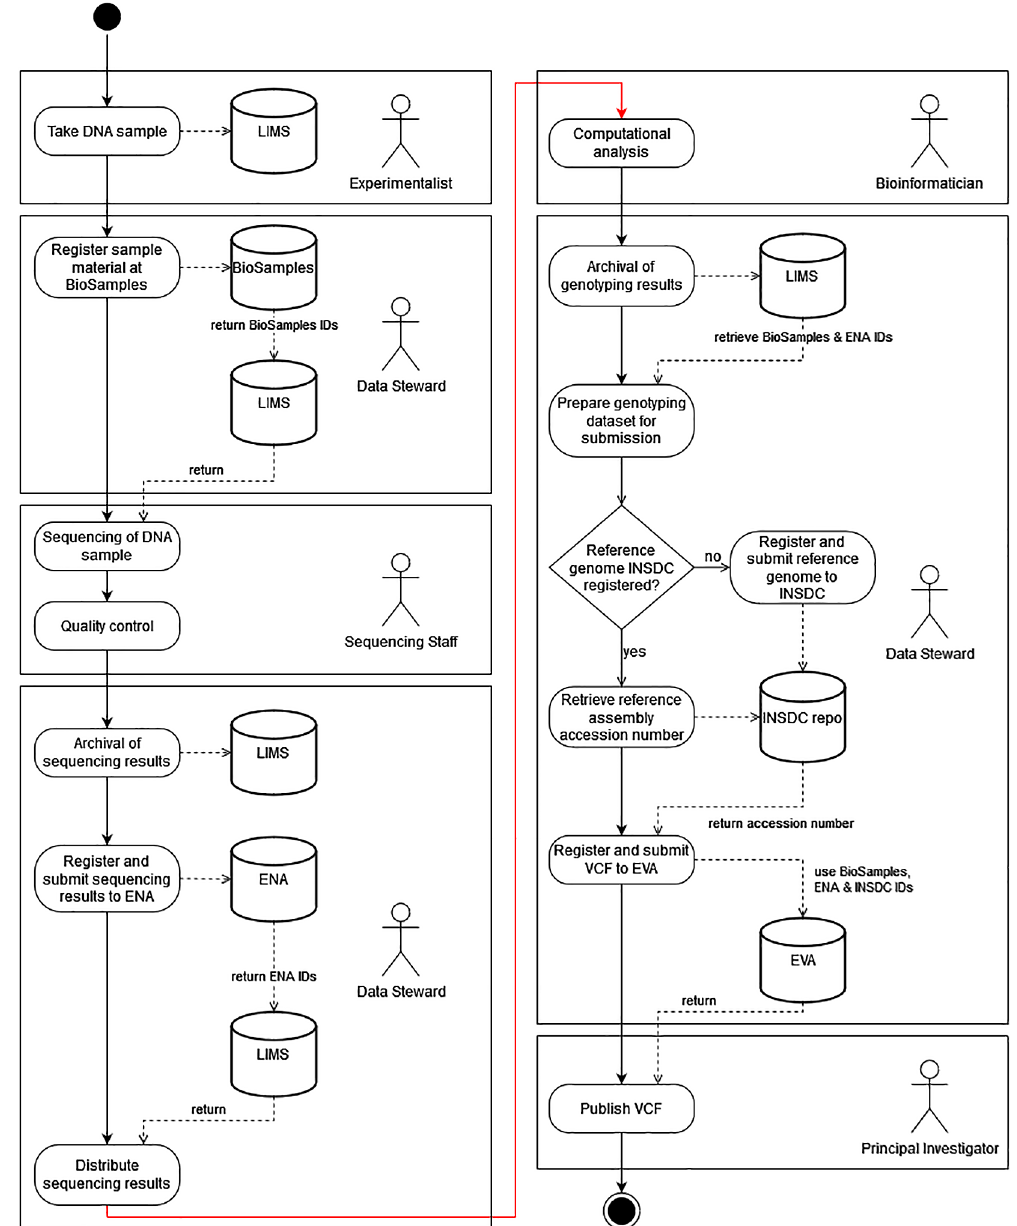
Figure 2. The recommended workflow for the submission of genotypic data to public EMBL-EBI databases. DNA samples are collected by an Experimentalist and their metadata are stored in a Laboratory Information Management System (LIMS). The Data Steward then registers these samples with BioSamples and in return receives unique BioSamples IDs back, which the Data Steward adds to the created samples in the LIMS. The sequencing and qualitycontrolofthesesamplesisthencarriedoutbytheSequencingStaffandtheprimarysequencedataisfedinto the LIMS and linked to the sample data by the Data Steward. The sequencing results are then registered and submitted tothe European Nucleotide Archive (ENA) using the BioSamples IDs tolink the initially submitted samples tothegeneratedsequencingreads.Thestudyidentifiers(ENAIDs)areassignedbyENAandaddedtothesamplesby the Data Steward in LIMS. The Bioinformatician then analyses the data and produces the genotyping results. Afterwards, the Data Steward prepares these data for transmission by linking them to the already created sample datafromtheLIMSandextractingtherequiredmetadataandaddingittotheheaderoftheVariantCallFormat(VCF) file. If the reference genome used for genotyping is not yet available in public repositories, it will now be transferred by the Data Steward to one of the International Nucleotide Sequence Database Collaboration (INSDC) databases. Otherwise, the metadata-enriched VCF file can be registered and submitted to the European Variation Archive (EVA). Theidentifiersassigned byEVA arethen transmittedbackand thePrincipalInvestigatorcanapprove thepublication of the